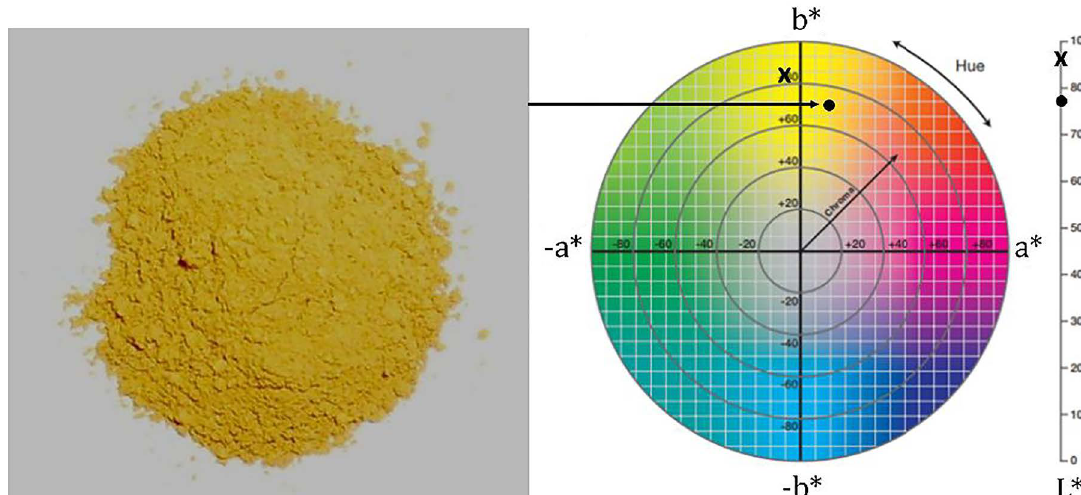
Figure 4. Photograph of the obtained powder (left) and CIELab chart (right) showing the color coordinates of the synthesized CdS-based pigment (●) compared to a commercial Cd-based yellow pigment ( x